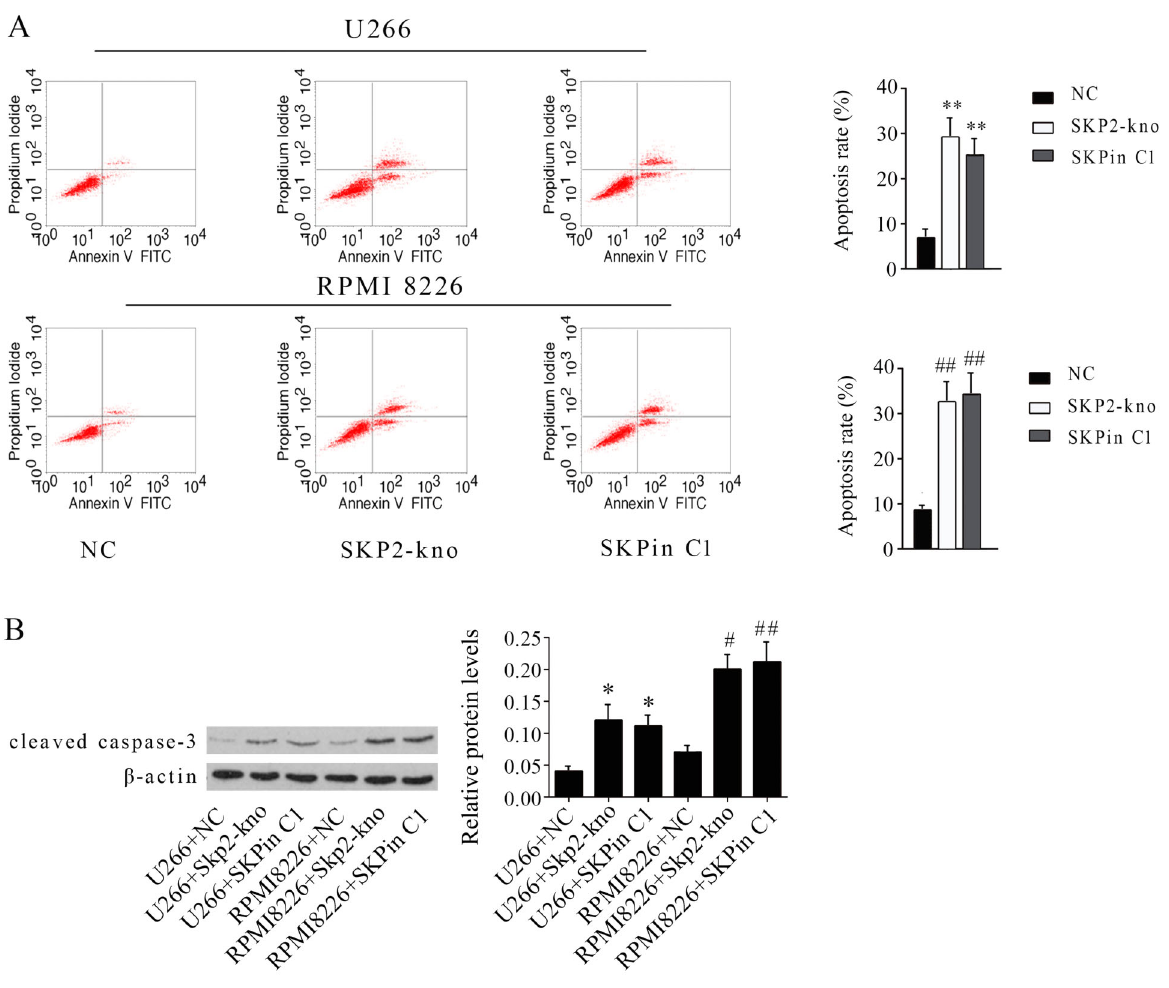
Figure 6. Effect of SKPin C1 treatment and SKP2 depletion on the apoptosis of U266 and RPMI 8226 cells treated with 25 m M SKPin C1 or transfected with the siRNA that targeted SKP2, evaluated using fl ow cytometry assay ( A ). Protein levels of cleaved caspase-3 were evaluated using western blot measurement ( B ). Data are reported as means ± SD. *P o 0.05, **P o 0.01 vs control group of U266 cells; # P o 0.05, ## P o 0.01 vs control group of RPMI 8226 cells (ANOVA). SKP2-kno: SKP2